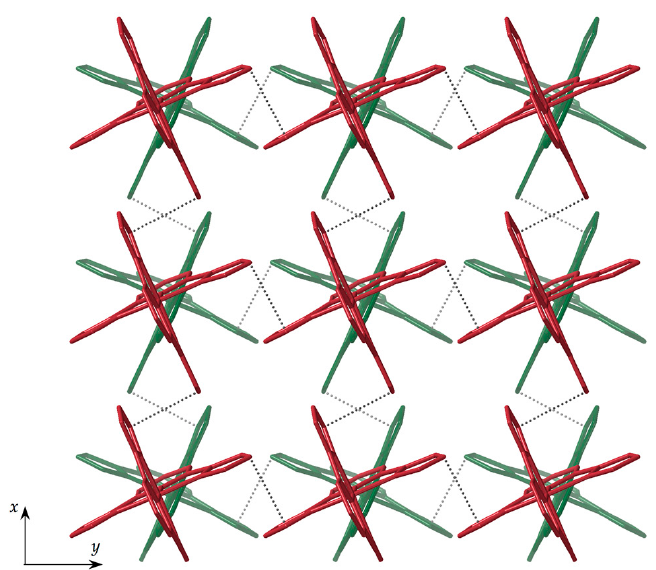
Figure 3. A view of the crystal packing of 1 · 4H 2 O parallel to the c axis showing two consecutive [Fe(bpp) 2 ] 2+ cationic layers in different colours (nicotinate anions and water molecules are omitted). The dotted lines refer to π - π stacking interactions. H atoms are not shown.